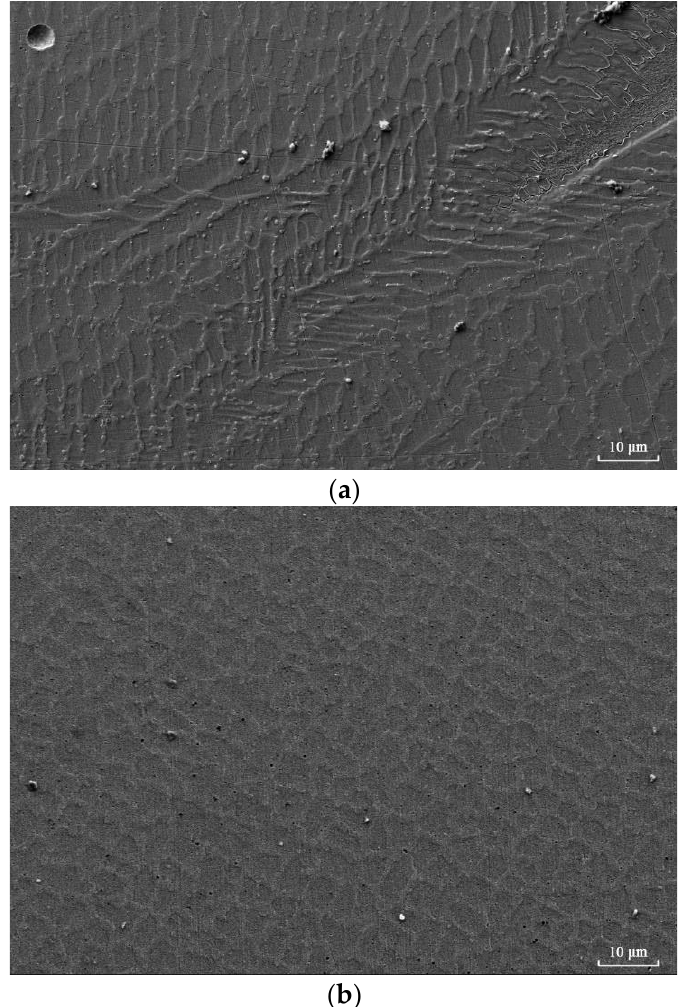
Figure 5. Microstructure in the top region of the deposited layer obtained by ( a ) laser deposition method and ( b ) laser-UHF induction hybrid deposition method.